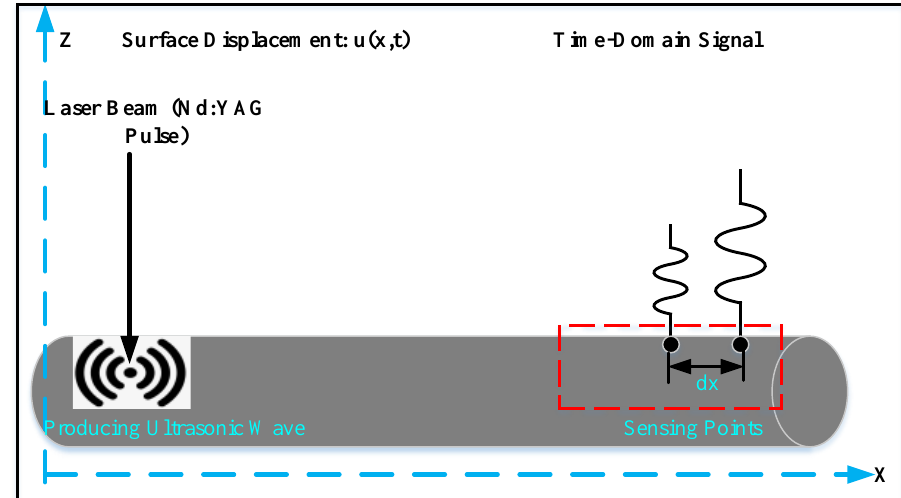
Figure 5. Schematic for laser ultrasonic corrosion monitoring method